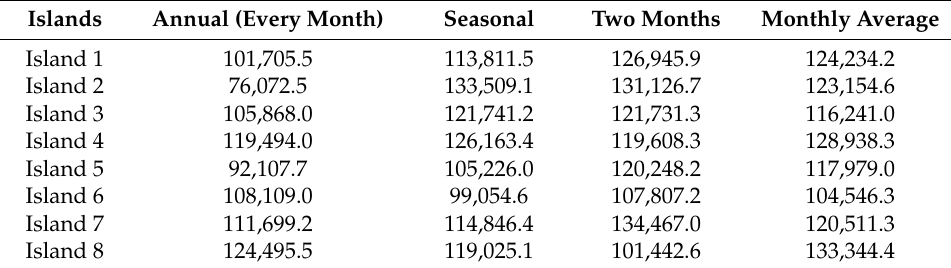
Table 7. Similarity analysis of microgrid facility configuration designed between real and estimated load patterns.